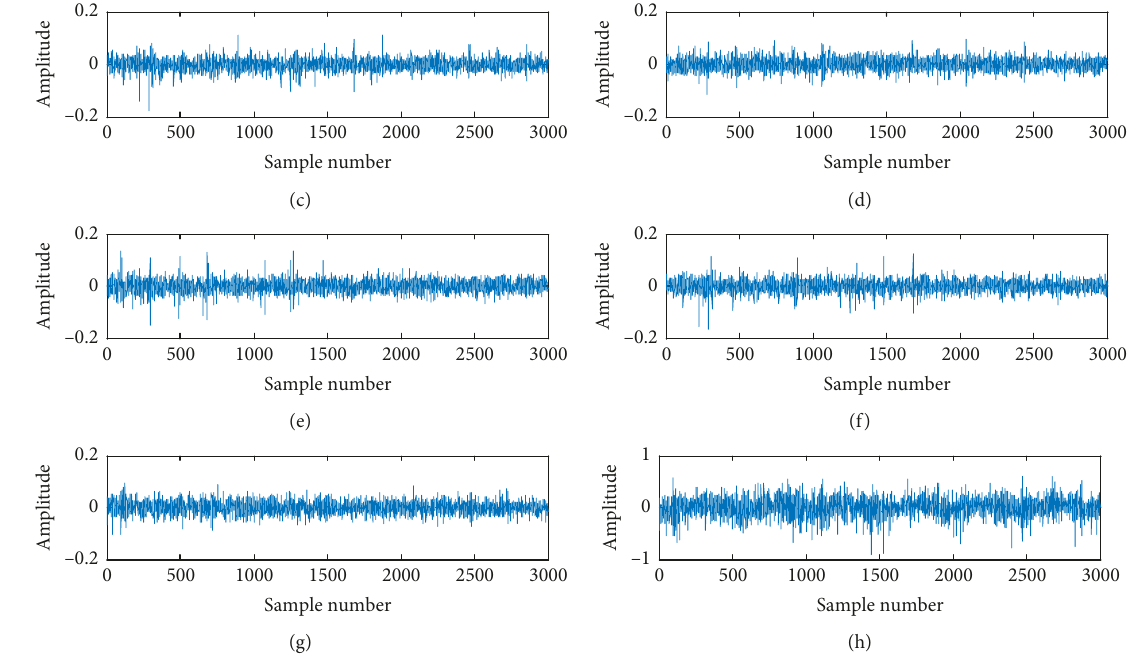
Figure 28: Multiresolution DMD modes of the broken teeth fault